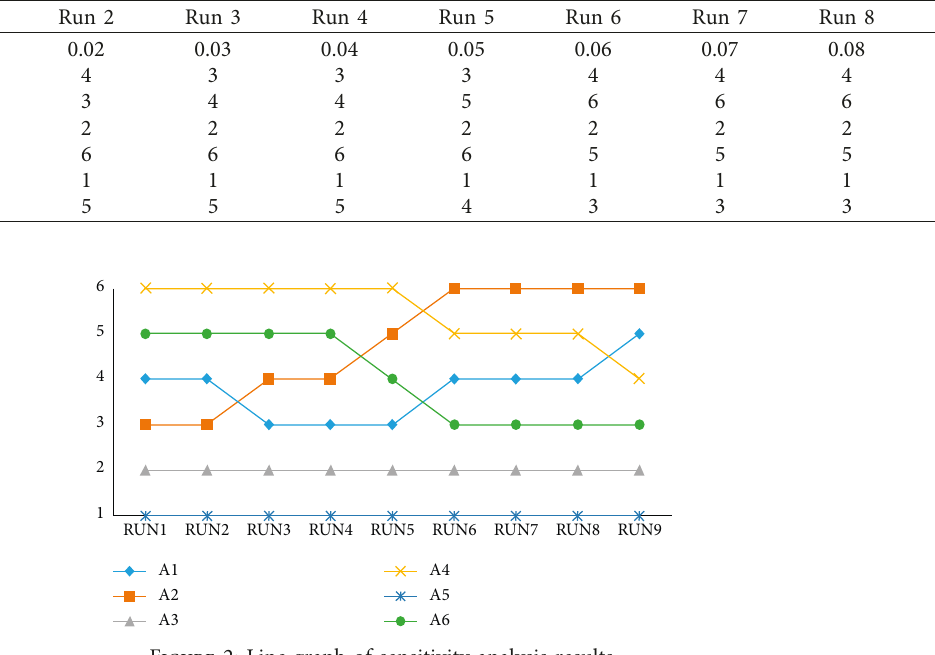
Table 16: The ranking of alternative partners by performing nine sensitivity analyses.